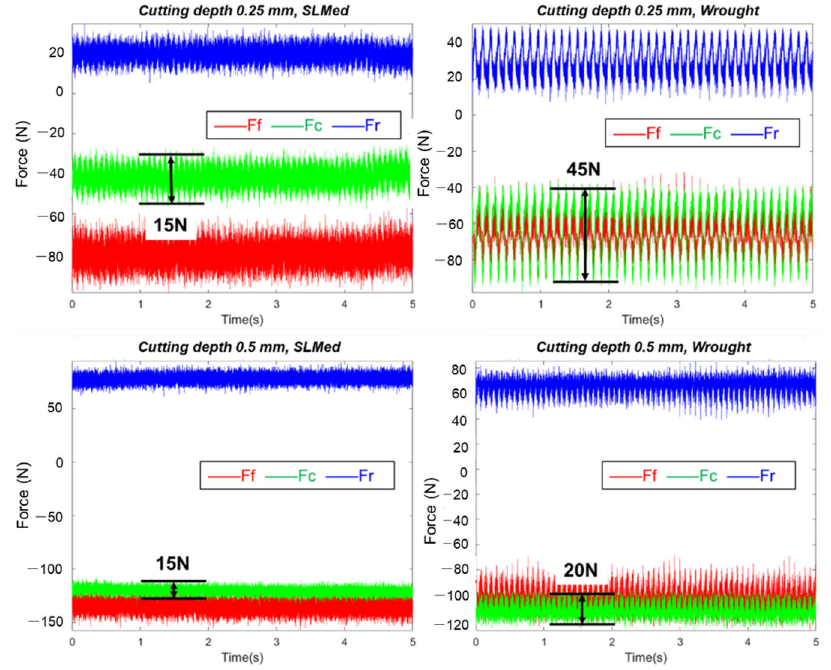
Figure 6. Cutting forces when machining wrought and SLMed Ti6Al4V workpieces at the cutting parameters of 0.1 mm/rev and 120 m/min.